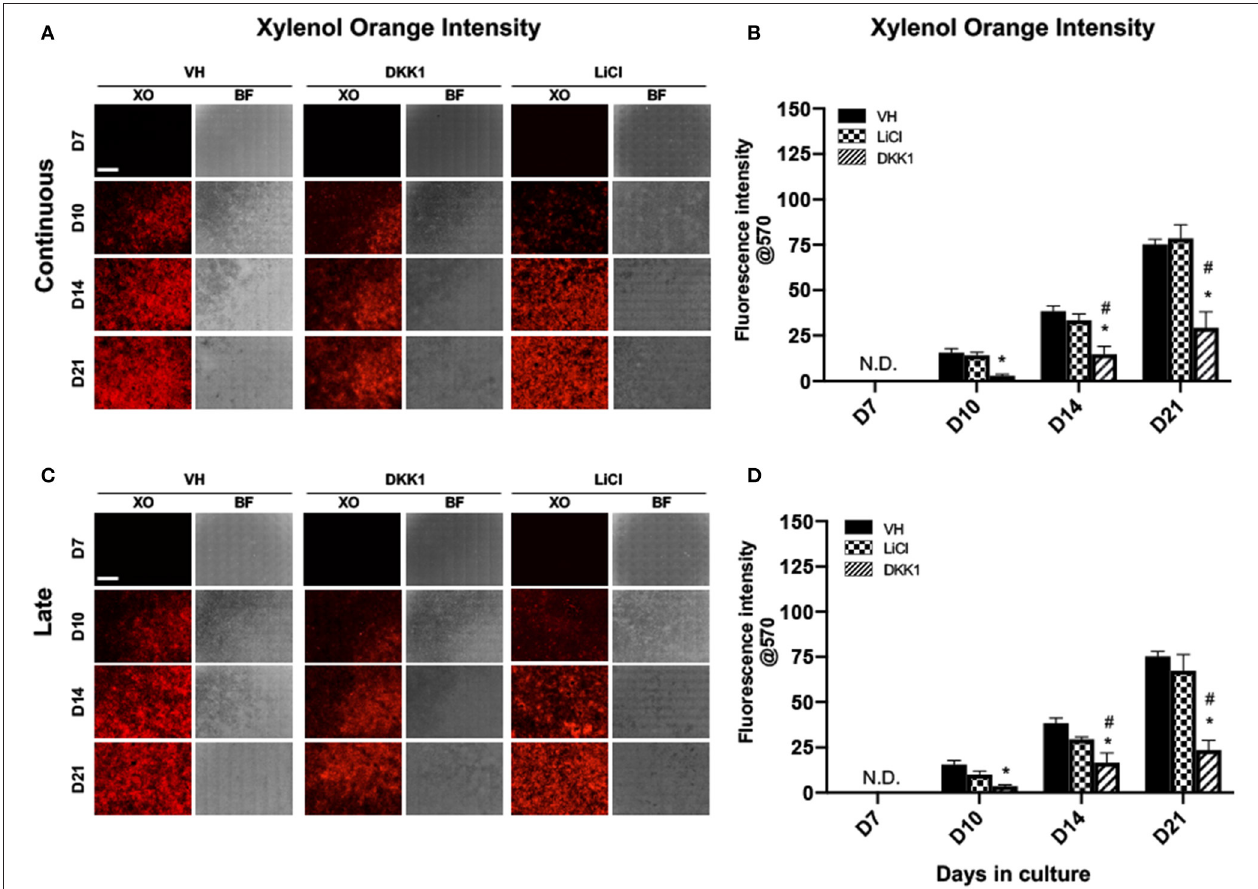
FIGURE 2 | Effects of LiCl on the mineralization of primary dental pulp cultures. Primary pulp cultures were treated with VH (0.1% BSA), DKK1 (50ng/ml) or LiCl (10mM) between days 3 and 21 (continuous, A,B ), and between days 7 and 21 (late, C,D ). (A,C) Representative images of the same areas in cultures treated with VH, DKK1, and LiCl continuously (A) and late (C) . Cultures were analyzed under brightfield (BF) and epifluorescent light using TRITC red filter for detection of XO staining. Scale bar = 2mm. (B,D) Graphs showing changes in the intensity of XO staining (in absolute values) in cultures treated with VH, DKK1, and LiCl continuously (B) , and late (D) . Continuous and late exposure to LiCl had no significant effect on the intensity of XO. Continuous and late exposure to DKK1 decreased the intensity of XO at days 10, 14, and 21 as compared to VH-treated and LiCl-treated cultures. Results represent mean ± SEM of at least 3 independent experiments. Analysis was performed using 1-way analysis of variance. * P ≤ 0.05 relative to VH at each time point; # P ≤ 0.05 relative to LiCl at each time point. XO, Xylenol orange; N.D, not